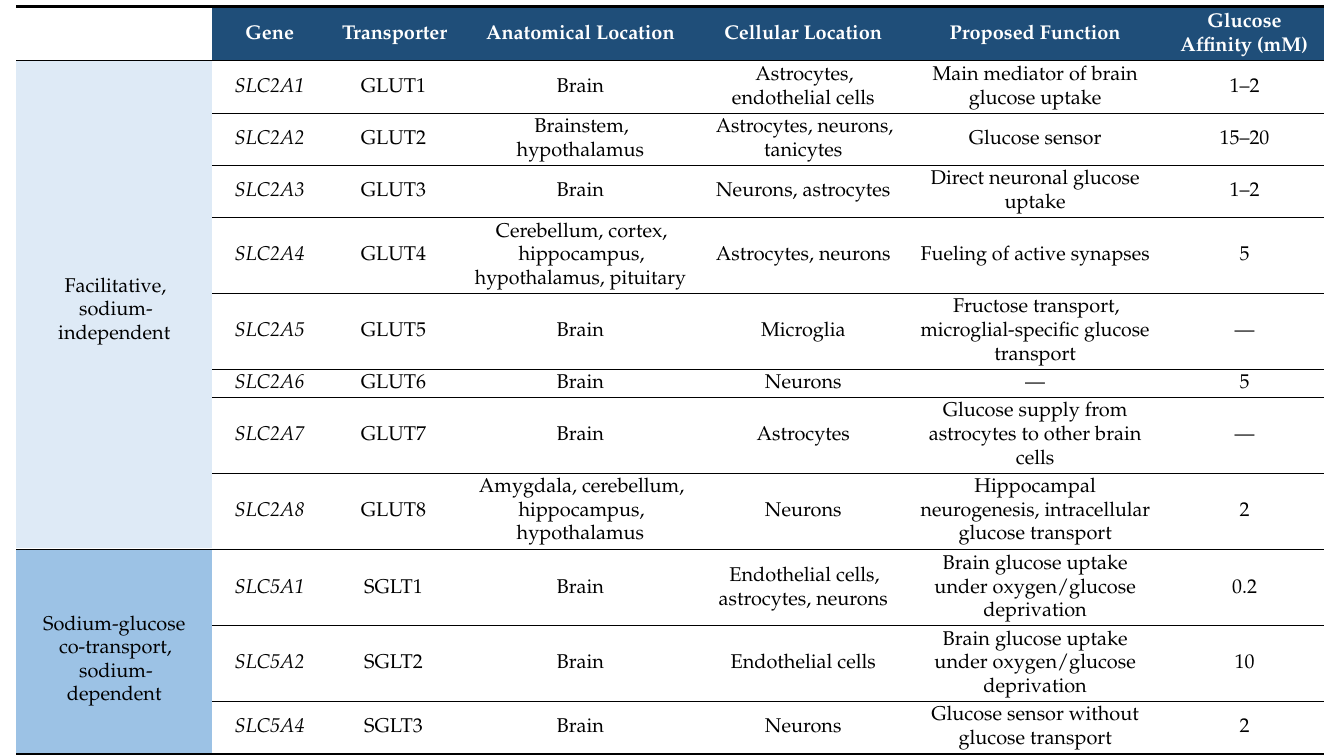
Table 1. The facilitative glucose transporters (GLUTs) and sodium-dependent glucose co-transporters (SGLTs) in the human nervous system.